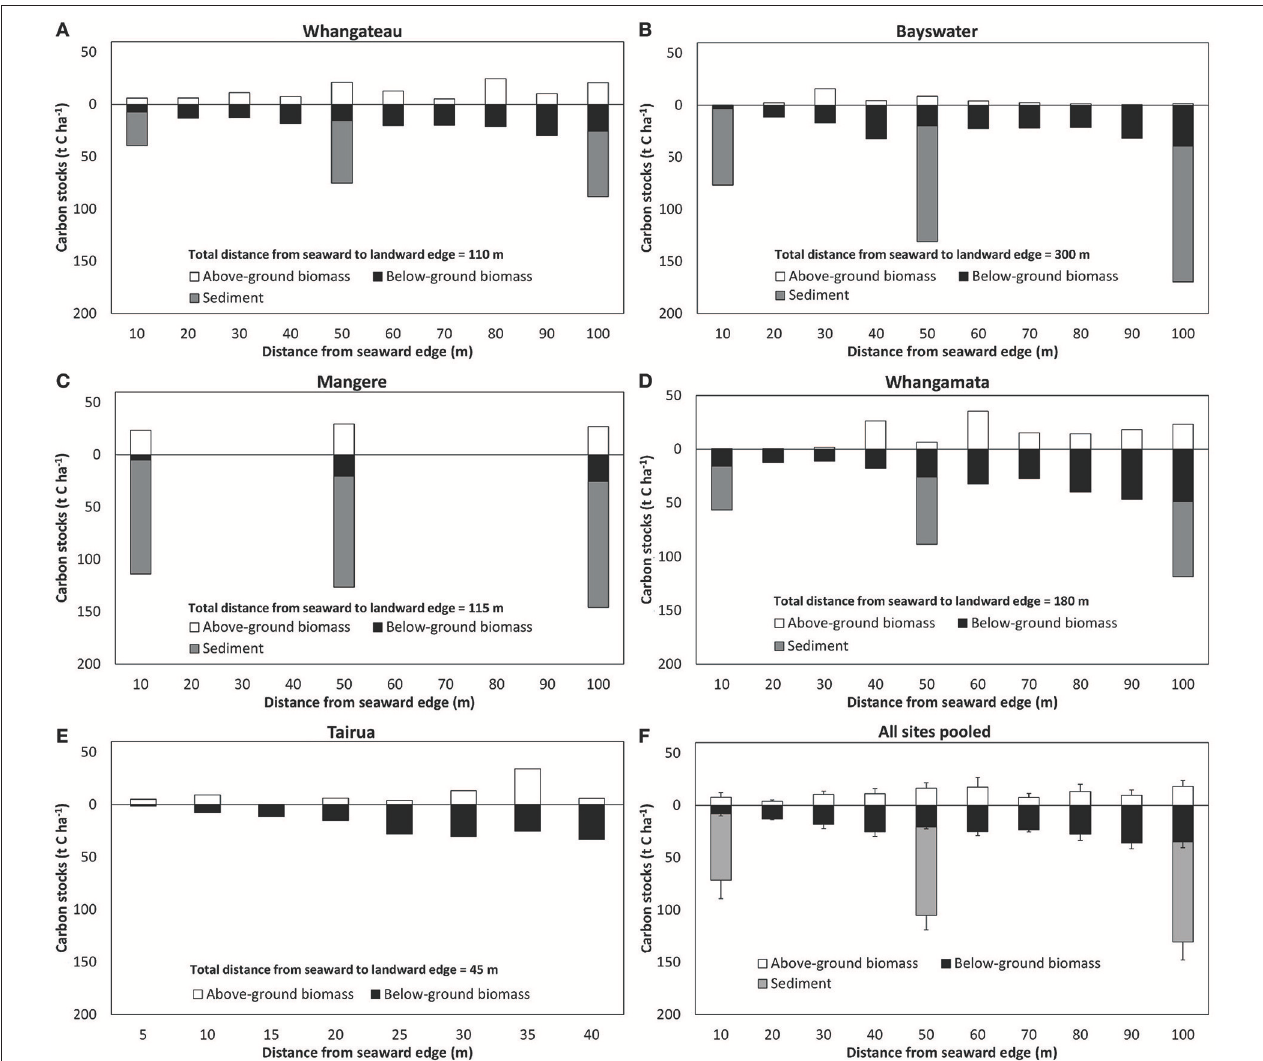
FIGURE 4 | Above and below-ground C stocks in Avicennia marina subsp. australasica forests with distance from the seaward edge. (A–E) are individual sites ( n = 1 per sampling position), (F) . All sites pooled values are mean ± SE ( n = 5 sites). Below-ground C values to 100cm depth, and below-ground biomass values extrapolated to 100cm depth as detailed in the methodology. Note difference in x axis for Tairua due to modified sampling design for this narrower mangrove stand, and lack of sediment cores taken at Tairua. Sediment samples were only collected at 10, 50, and 100m positions from the seaward